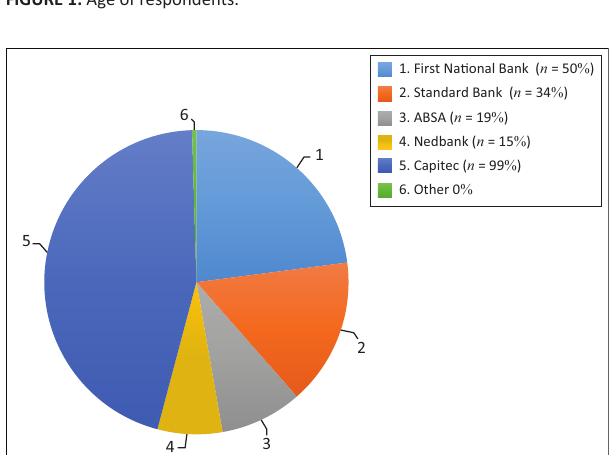
FIGURE 1: Age of